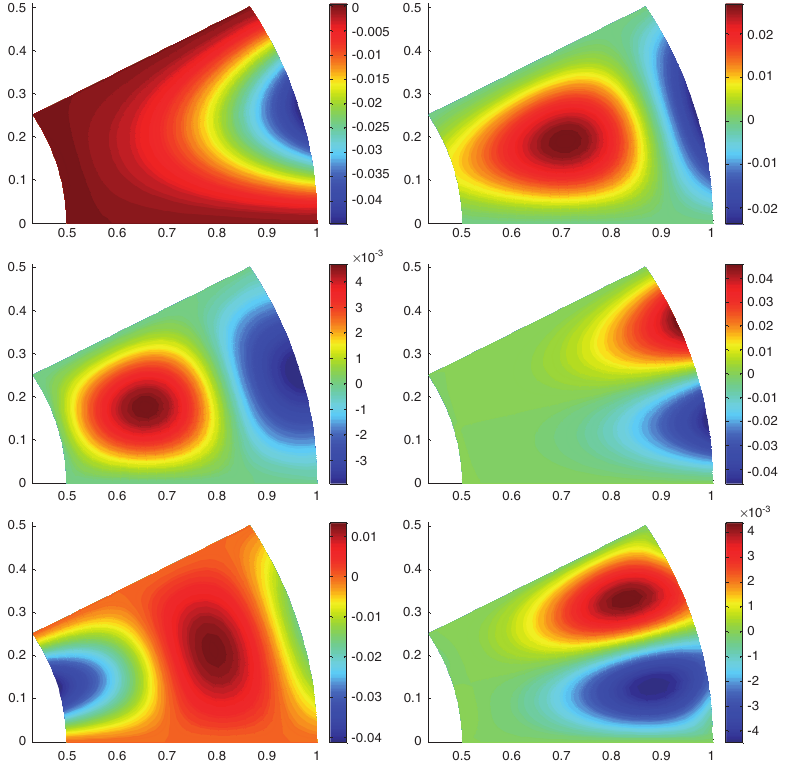
Figure 5 The first six mode shapes of an isotropic FG annular sector plate clamped at the radial edges for n = 1 and θ = 30 ° .